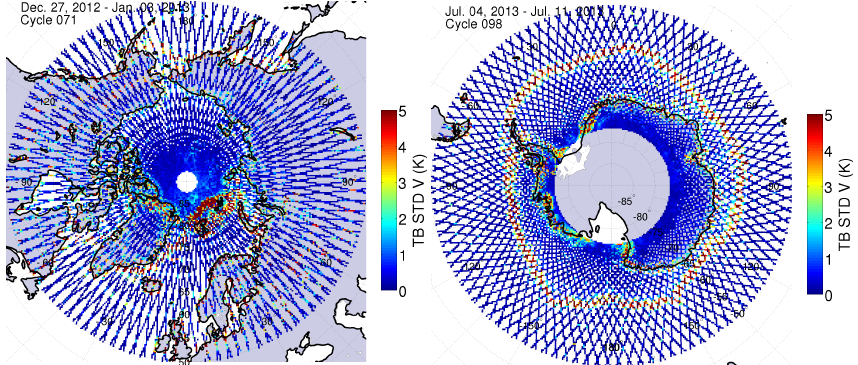
Fig. 2. Standard deviation of radiometer 3 TB V observations during (left) the cycle 71 over the NH and (right) the cycle 98 over the SH.